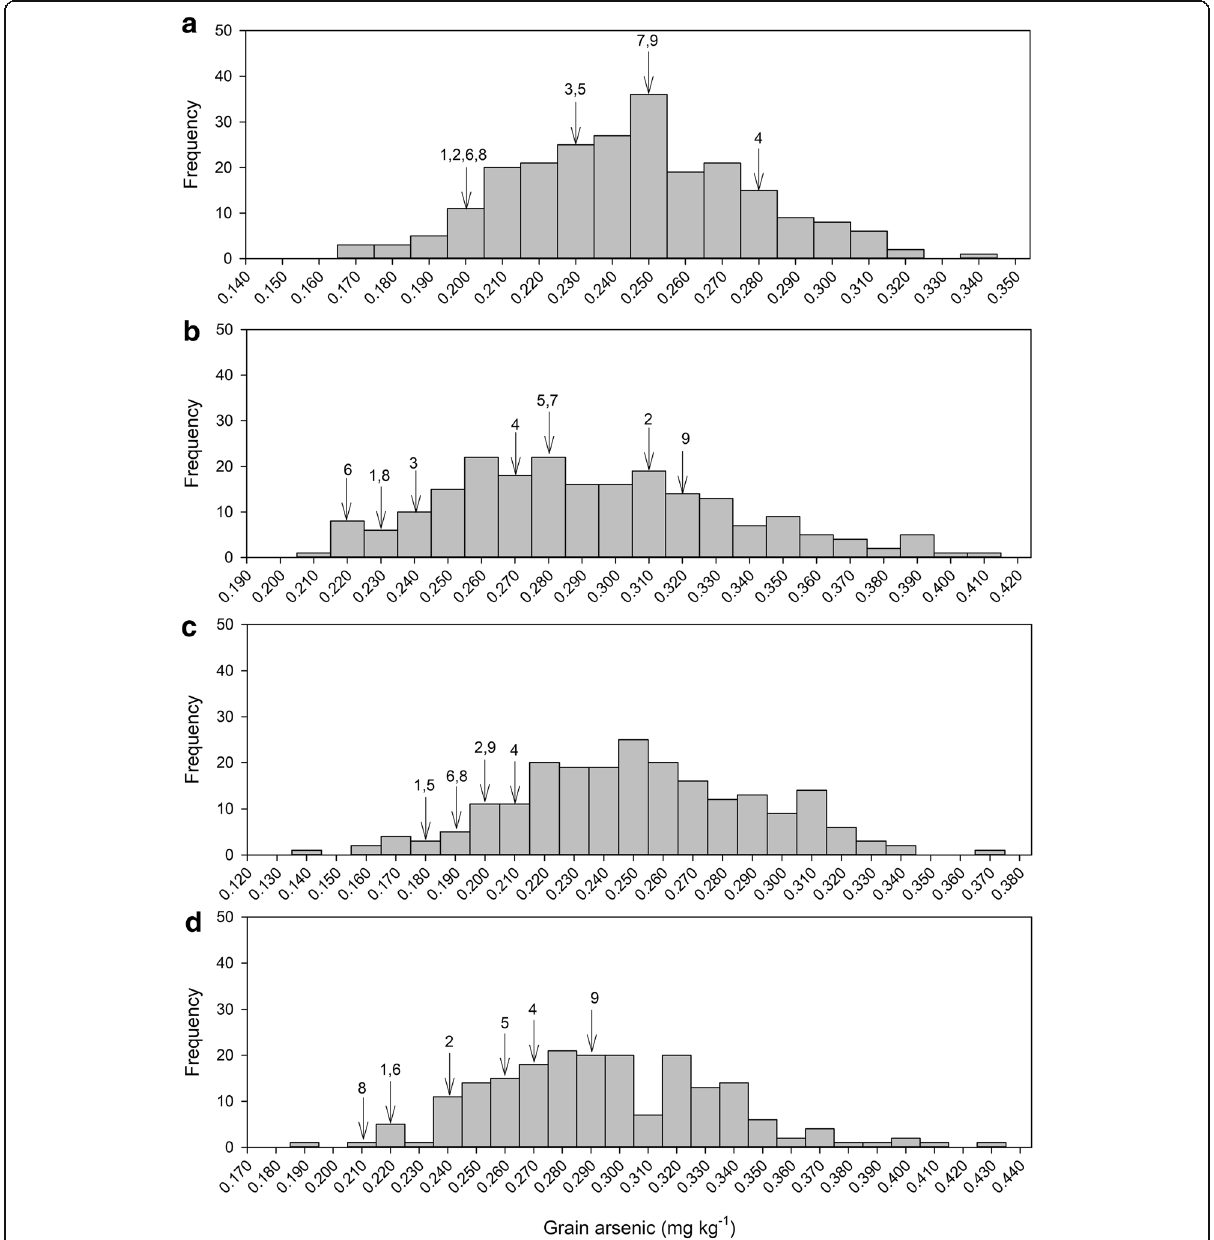
Fig. 6 Grain arsenic concentration for the BAAP in the four experiments a AWD year 1. b CF year 1. c AWD year 2. d CF year 2. The grain arsenic concentration of the high yielding elite Bangladeshi cultivars is indicated by arrows 1) BR 3; 2) BR 6; 3) BR16; 4) BRRI dhan28; 5) BRRI dhan 45; 6) BRRI dhan 47; 7) BRRI dhan50; 8) BINA dhan5; 9) Iratom